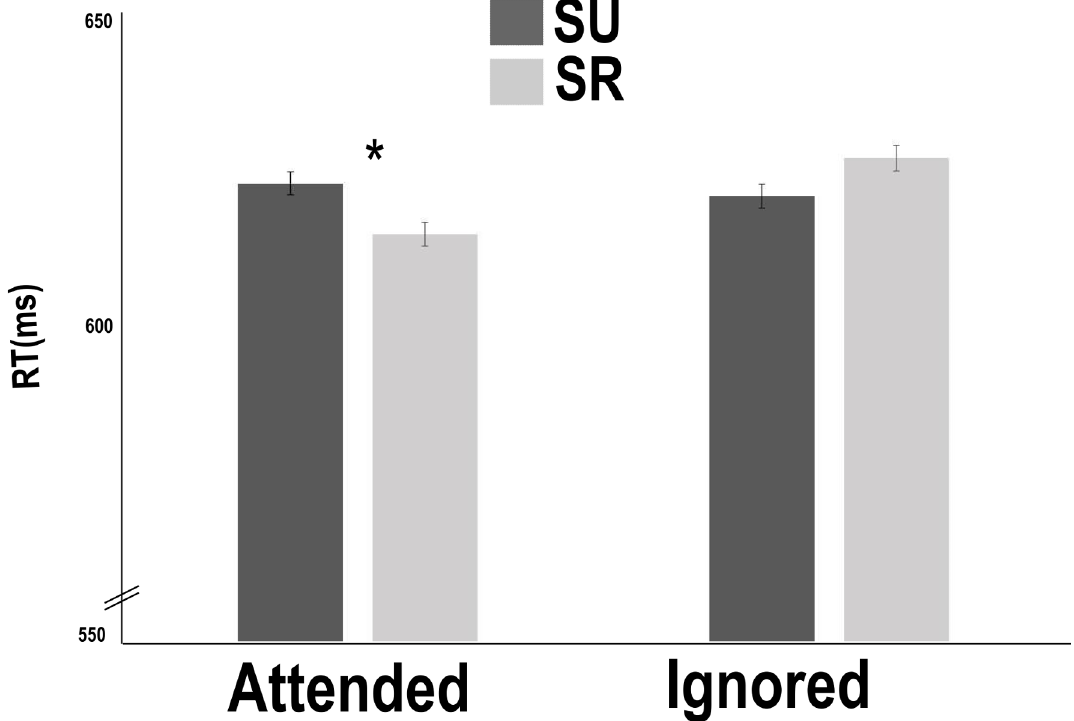
Fig 3. Priming effect results. A significantinteraction betweenattention and semanticpriming effect in terms of reaction times. The results showedthat in the attendedcondition,the semanticallyrelated (SEMR) items were recognized faster than semantically unrelated(SEMU) items, while this difference was absent for the